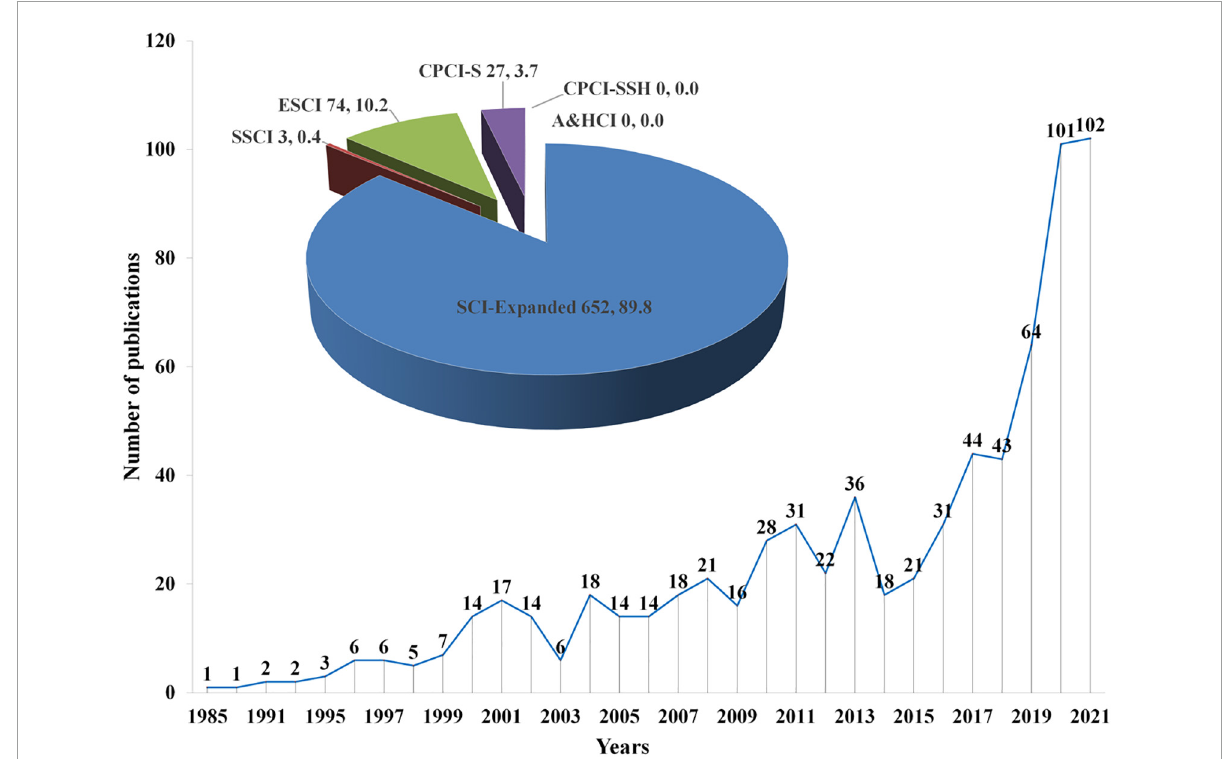
FIGURE2 Growth trend of the Web of Science documents “fulminant myocarditis” research over the last 30 years.